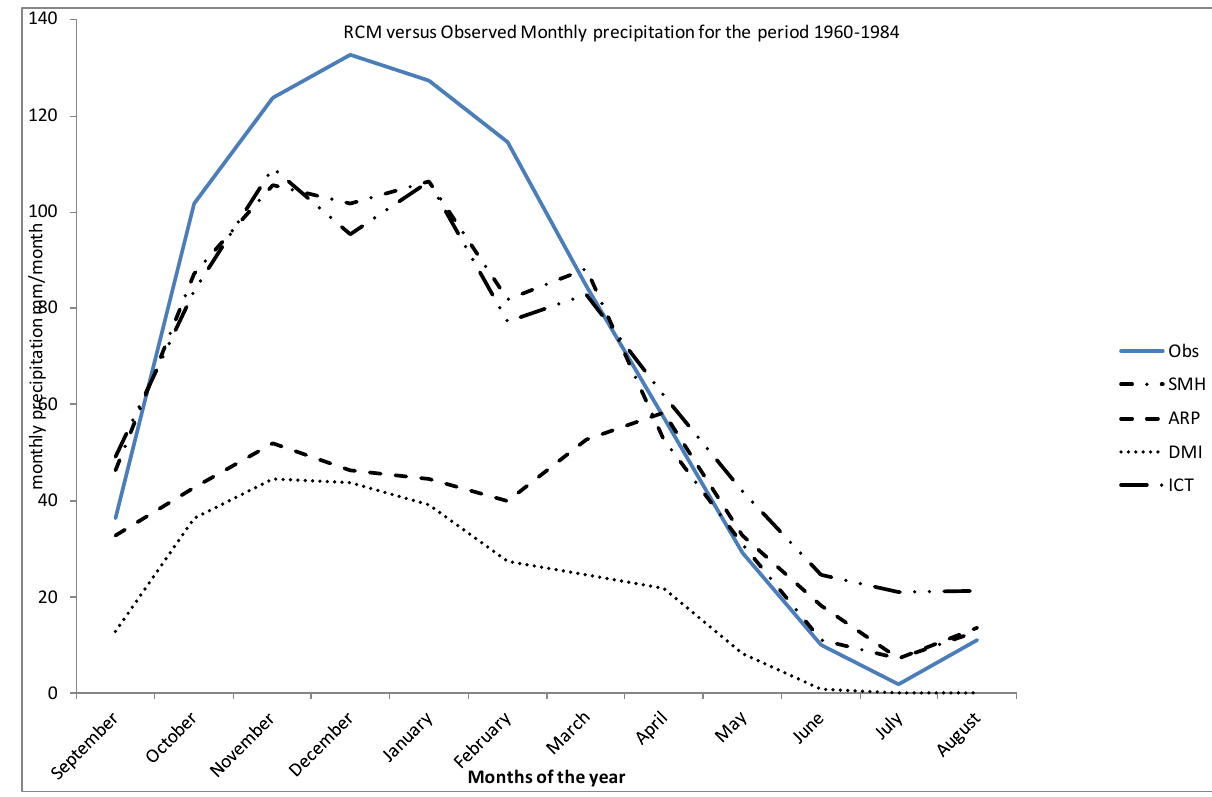
Figure 5. Seasonal variability of precipitation (ground data and RCM